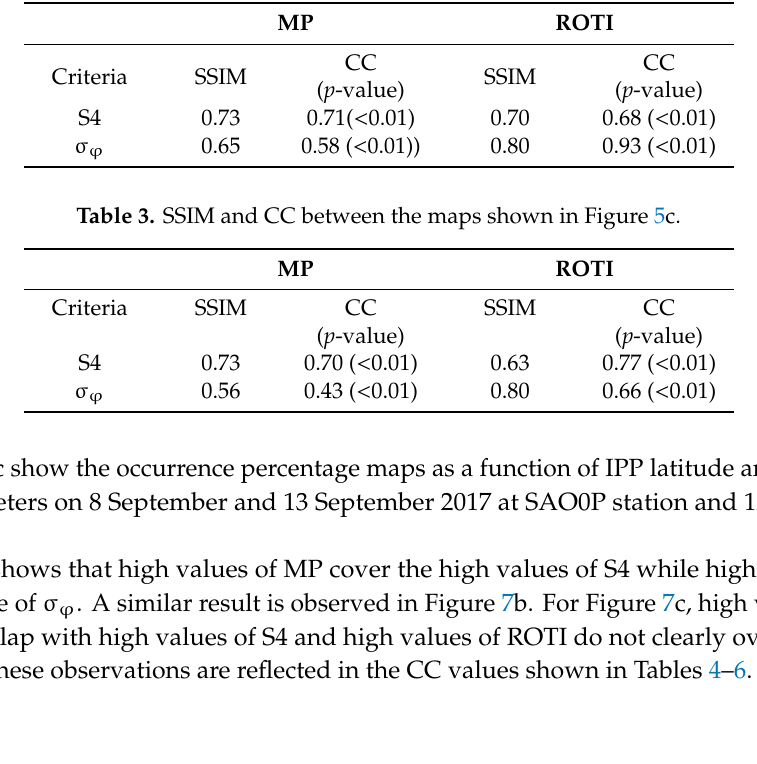
Table 2. SSIM and CC between the maps shown in Figure 5b.